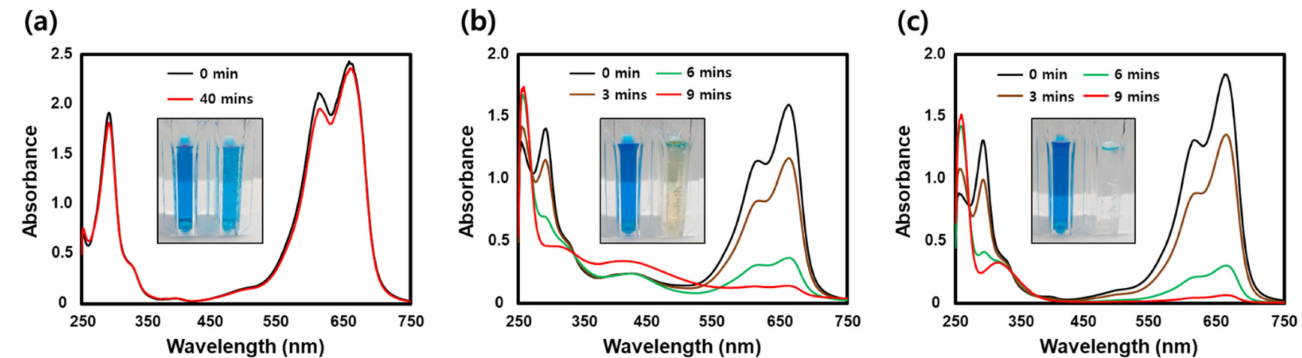
Figure 7. UV–Vis spectra of methylene blue (MB) dye reduction in the presence of different catalysts, ( a ) NaBH 4 , ( b ) SS-AgNPs, and ( c )